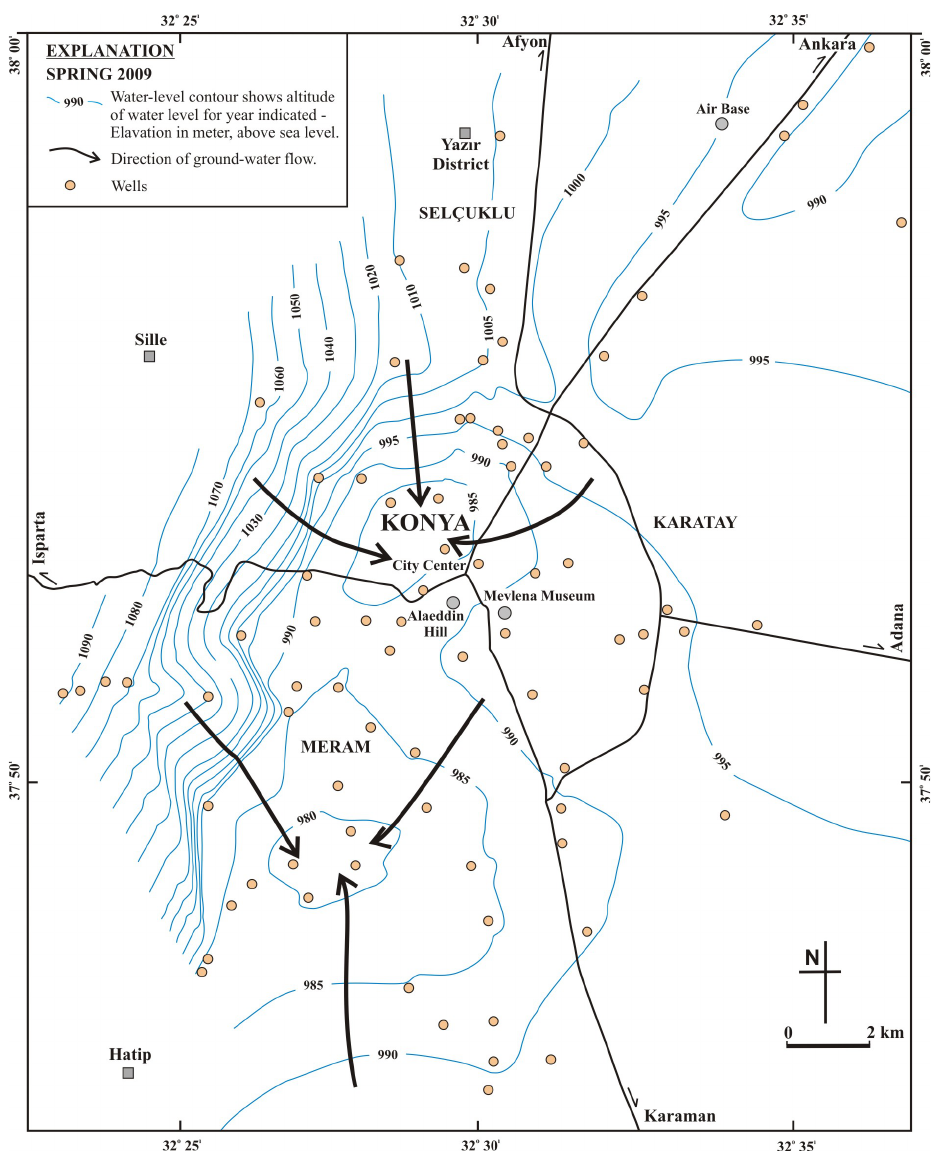
Fig. 4. Ground water table map of the Konya sub-basin (modified from Bulduk,